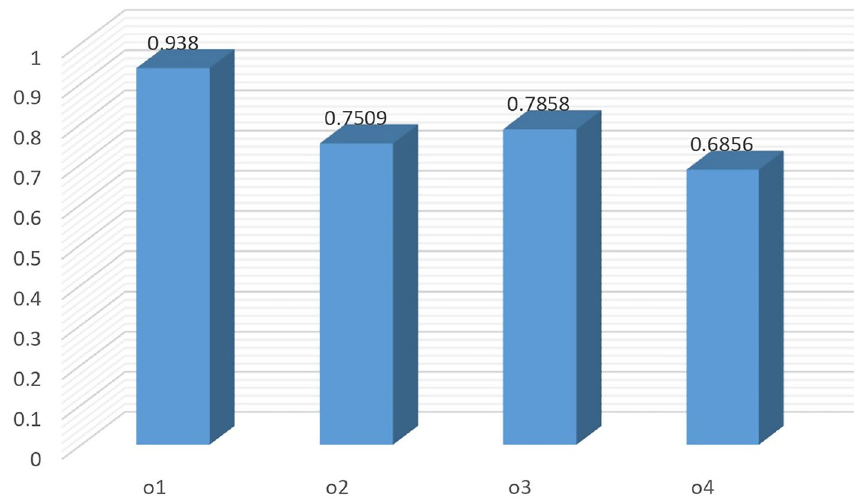
Figure 4. Ranking results when ̟ 1 = 0.2 , ̟ 2 = 0.343 and ̟ 3 = 0.457 .